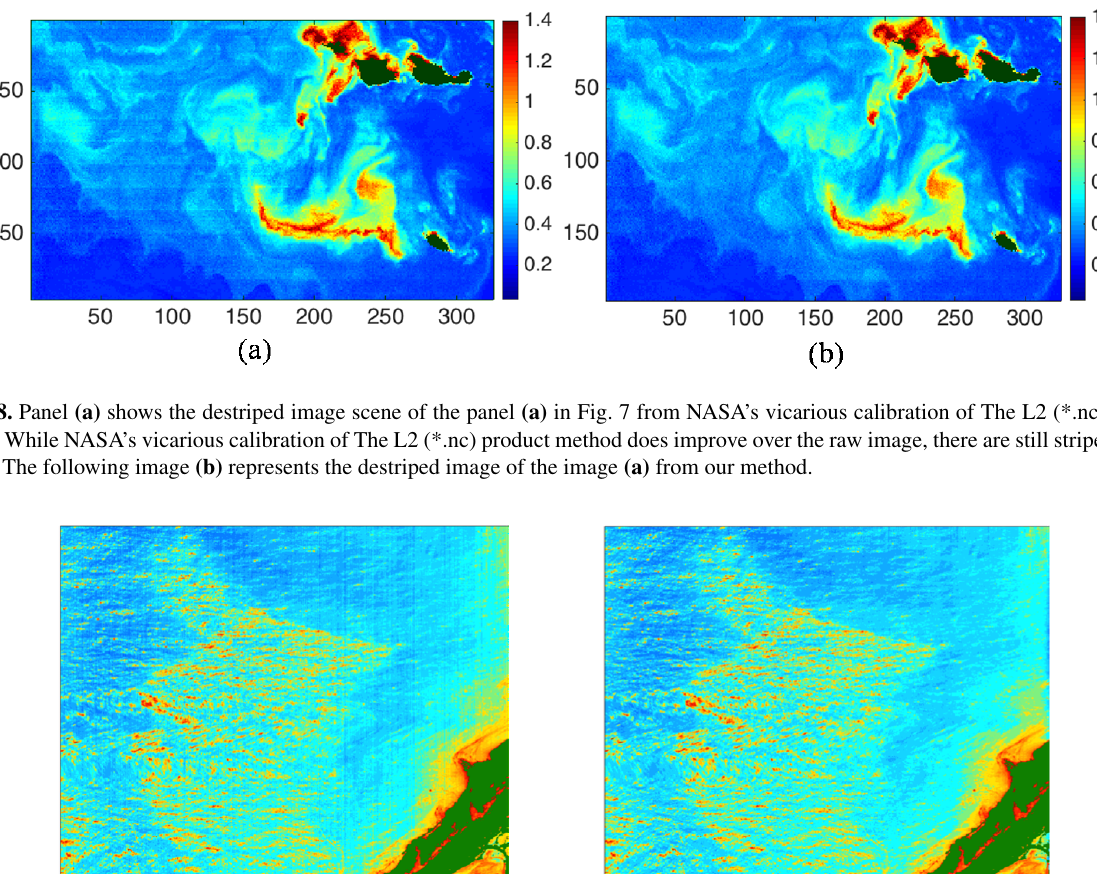
selected from the U -curve method, as explained in Sect.